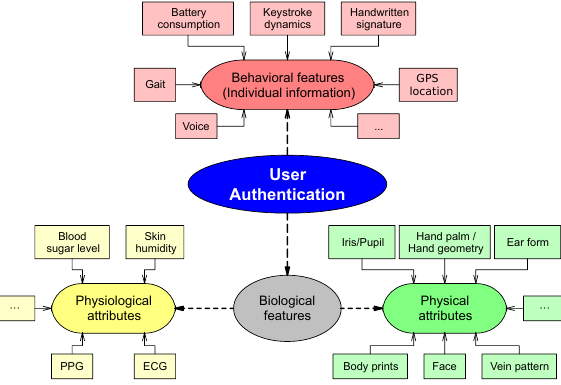
Figure 1. Features scheme for sensor-based user